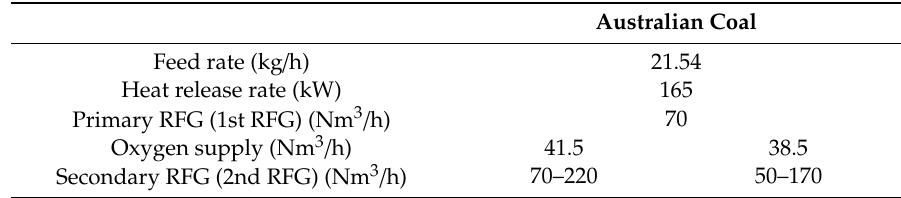
Table 2. Parameters of the Australian coal used in the oxy-combustion experiments (RFG: recirculated flue